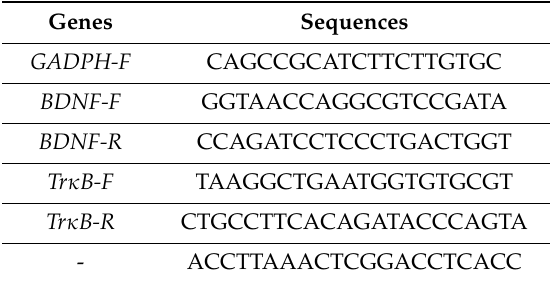
Table 1. The PCR primer